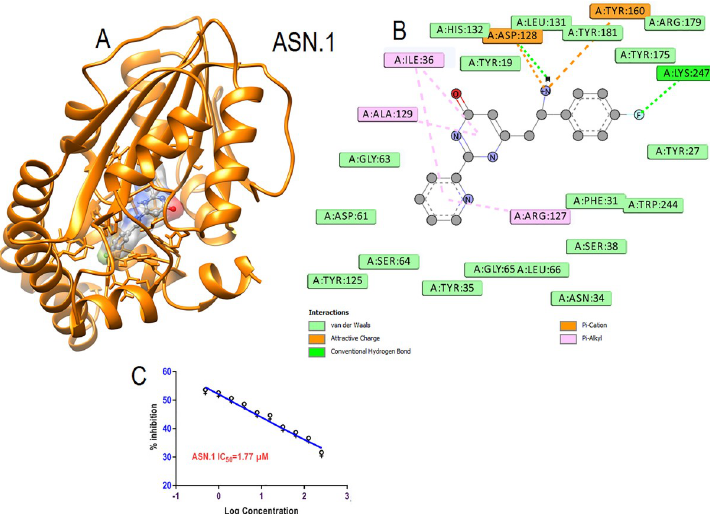
Fig 5. (A) Interaction of primary hits (ASN.1) is shown in element color ball and stick in surface view within the active pocket of Pf PMT. (B) 2D interaction with amino acids within five Å of interaction. (C) Schizonticidal activity (IC 50 )against growth of Plasmodium falciparum parasite culture.